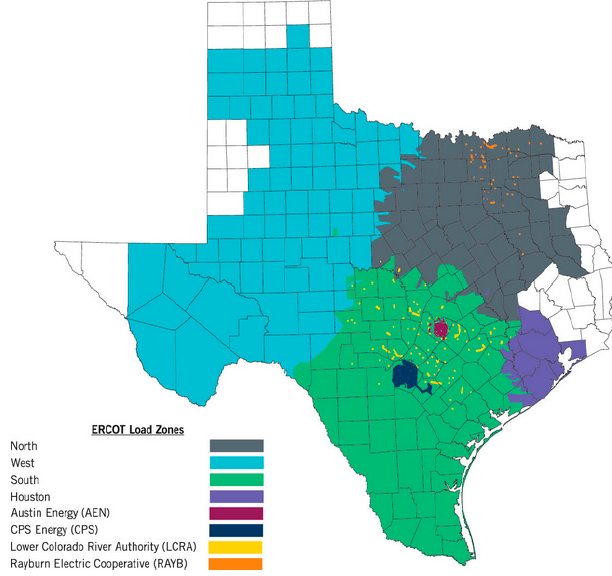
Figure 1. The eight ERCOT zones (Source: www.ercot.com, accessed on 18 July 2020).